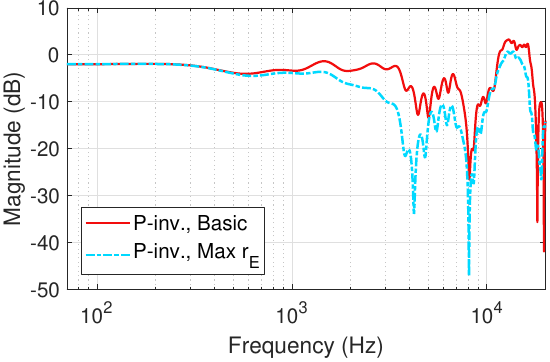
Figure 2. Example of the high-frequency differences of decoding with and without Max r E weighting-